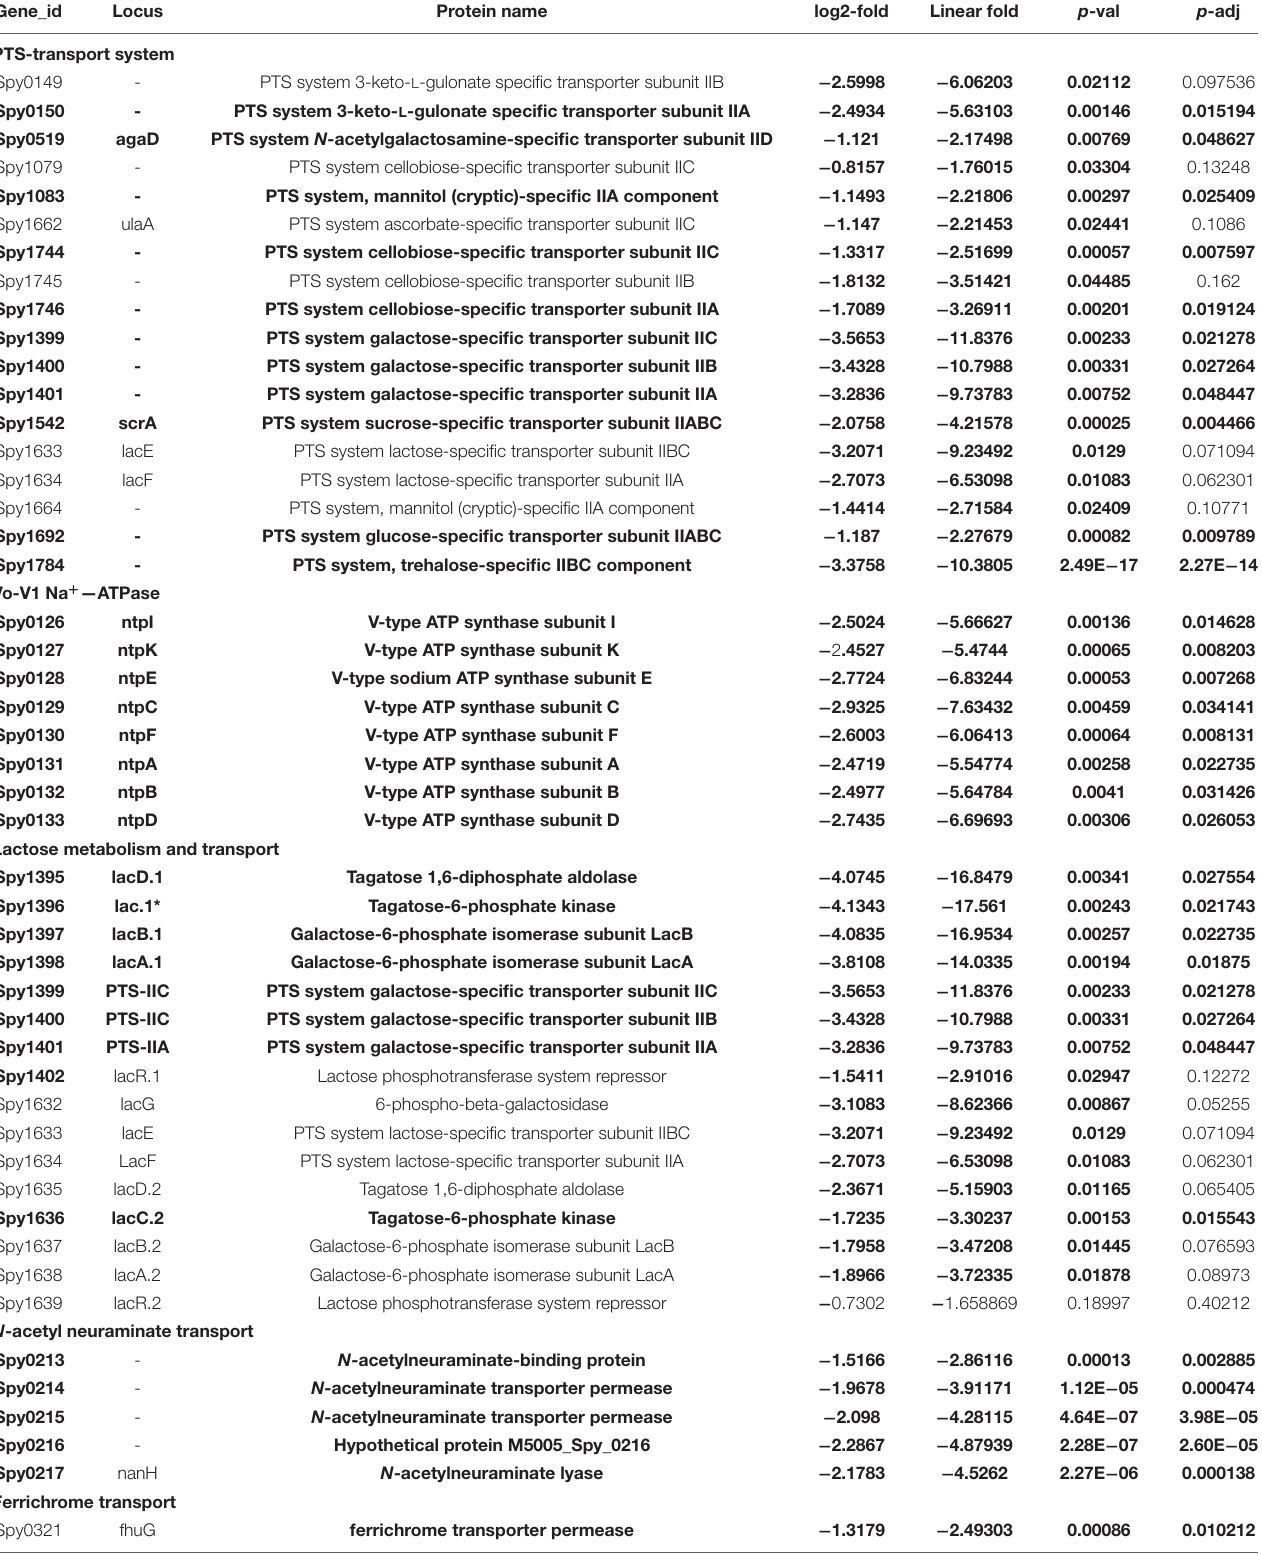
TABLE 2 | Transcript abundance of the major down-regulated clustered genes in S. pyogenes in the absence of SP-TyK. Gene_id Locus Protein name log2-fold Linear fold p -val p